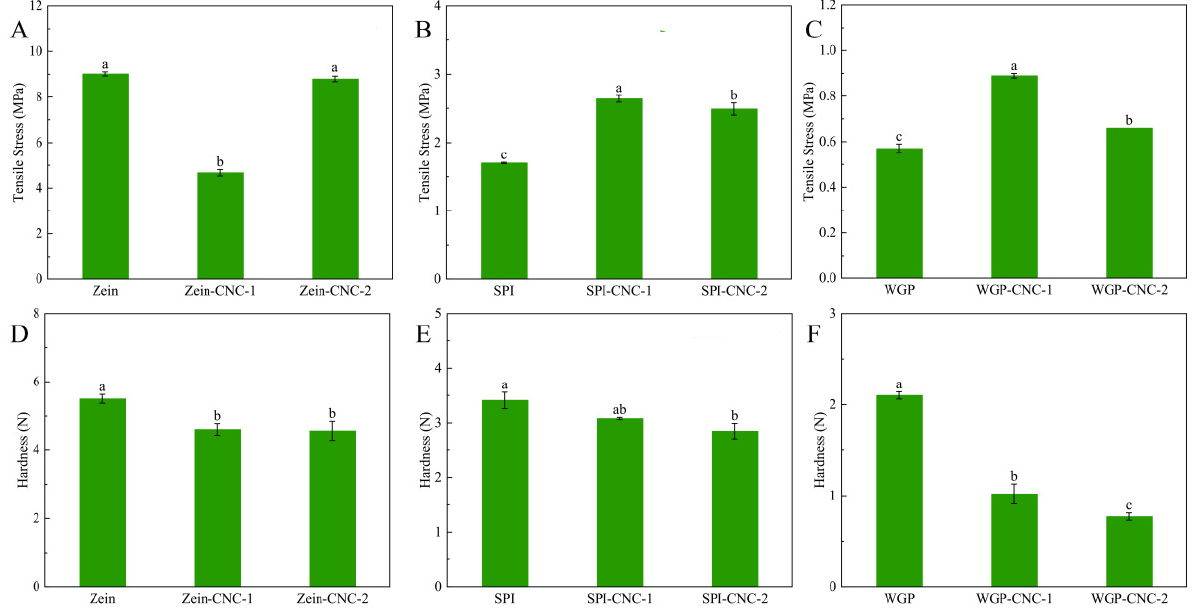
Figure 3. Tensile stress ( A – C ) and hardness ( D – F ) of the Zein/SPI/WGP-based films. Different letters (a–c) indicated significant differences ( p < 0.05).